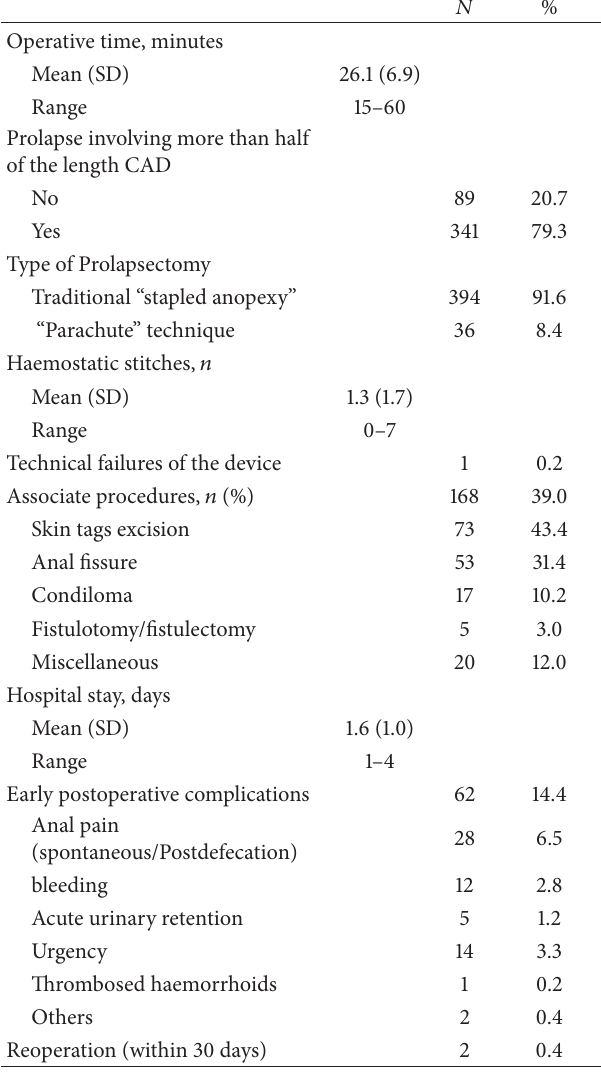
Table 2: Intra- and early postoperative findings ( 𝑁 = 430